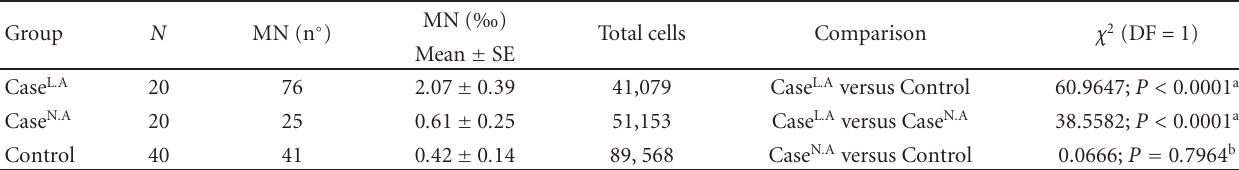
Table 2: Micronucleus (MN) analysis.